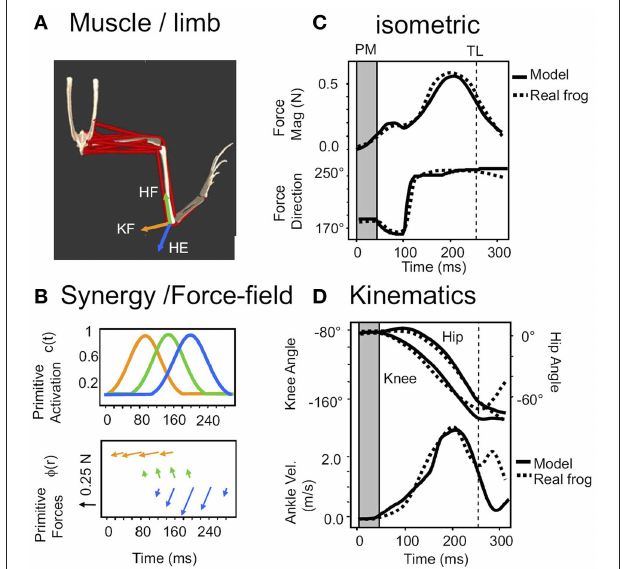
FIGURE 4 | The system of reflex and ISMS activated primitives is sufficient to accurately model reflex generated behaviors. Reproduced from Kargo et al. (2010) with permission. (A) The simulation scheme in Figure 3 is implemented in Opensim as a frog biomechanical model. (B) Combinations of pulsed synergies driving force-fields, sequenced by a combination of central and afferent feedback modulations of pattern organize limb force/torque patterns. (C) These can replicate the force production under isometric conditions (dotted lines-measured data of a spinal bullfrog, solid lines- opensim prediction). (D) Given the viscoelastic model of muscle and afferent feedback based reduction of pulse activations in a moving system the open sim model reproduces joint kinematics and ankle (effectively the tool) motion in the wipe task. This suggests ISMS can be used to organize motion according to the same rules as natural reflex actions, modulo the concerns noted in Section A Program of ISMS Research Based on the Current “Known Unknowns .”